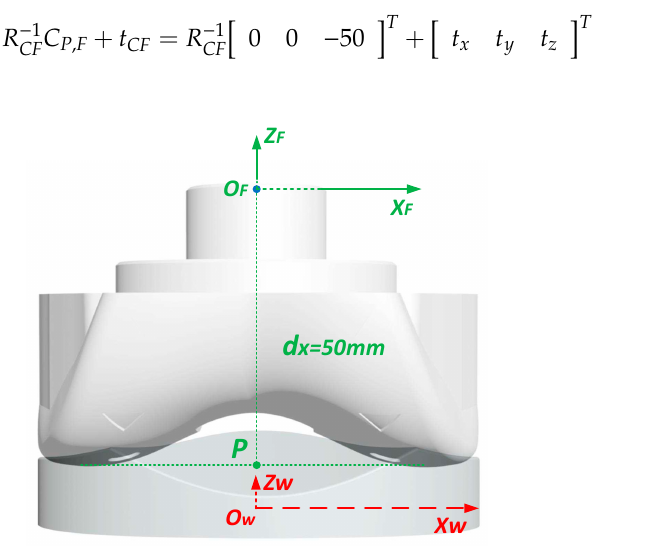
Figure 13. Kinetic pose reconstruction actually reconstructs the trajectory of point P in the femoral component.